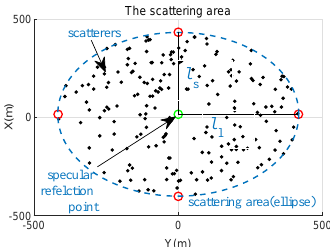
Figure 2. The structure of the scattering area(in XOY